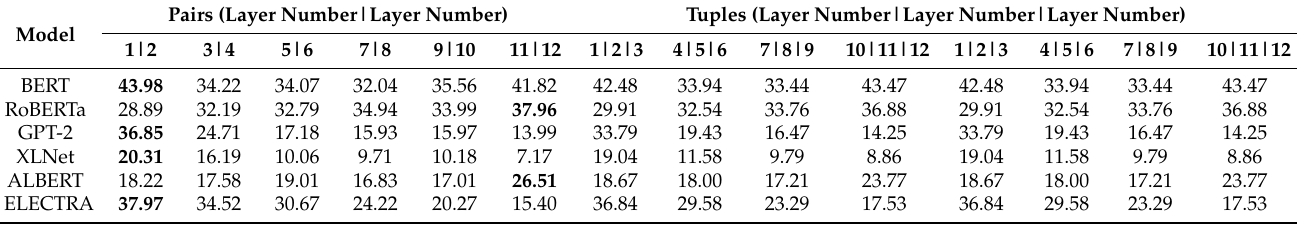
Table 3. Mean V-measure scores (in %) of the examined models with a concatenation of layers (the used layers are indicated by the numbers 1 to 12, where 1 is the top layer and 12 is the output layer) for sentence